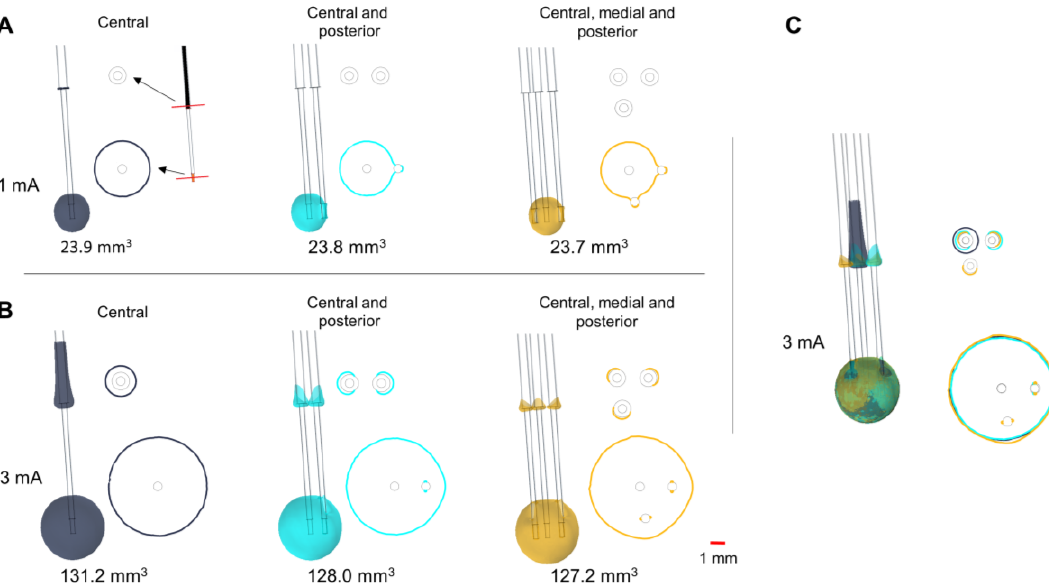
Figure 3. Influence of parallel MER trajectories inserted intraoperatively. EF distribution simulated in a homogeneous medium depicted with isosurfaces and isocontours of 0.2 V/mm. Isocontours obtained at perpendicular planes placed at the target and 12.5 mm above it (red lines shown in A) for stimulation using the central lead at ( A ) 1 mA and ( B ) 3 mA. ( C ) Superposition of the isosurfaces and the isocontours for the three cases at 3 mA. Single lead (dark blue), two leads (cyan), and three leads (yellow). Non active contacts of the posterior and medial leads were set to floating potential. Numbers below the leads indicate the EF volume covered by the 0.2 V/mm isosurface.